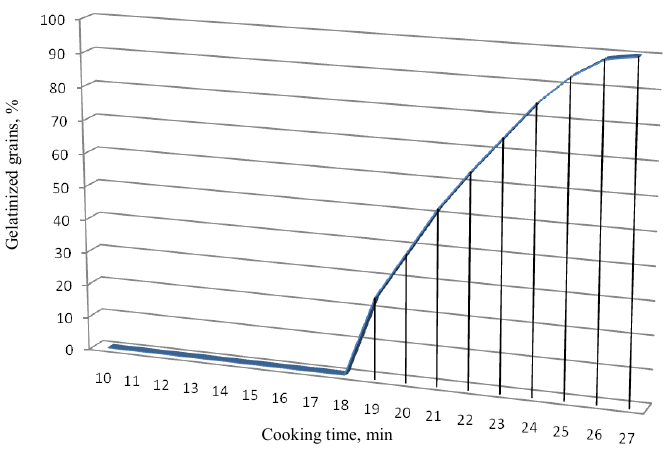
Figure 1. Gelatinization profile of Hashemi rice samples.